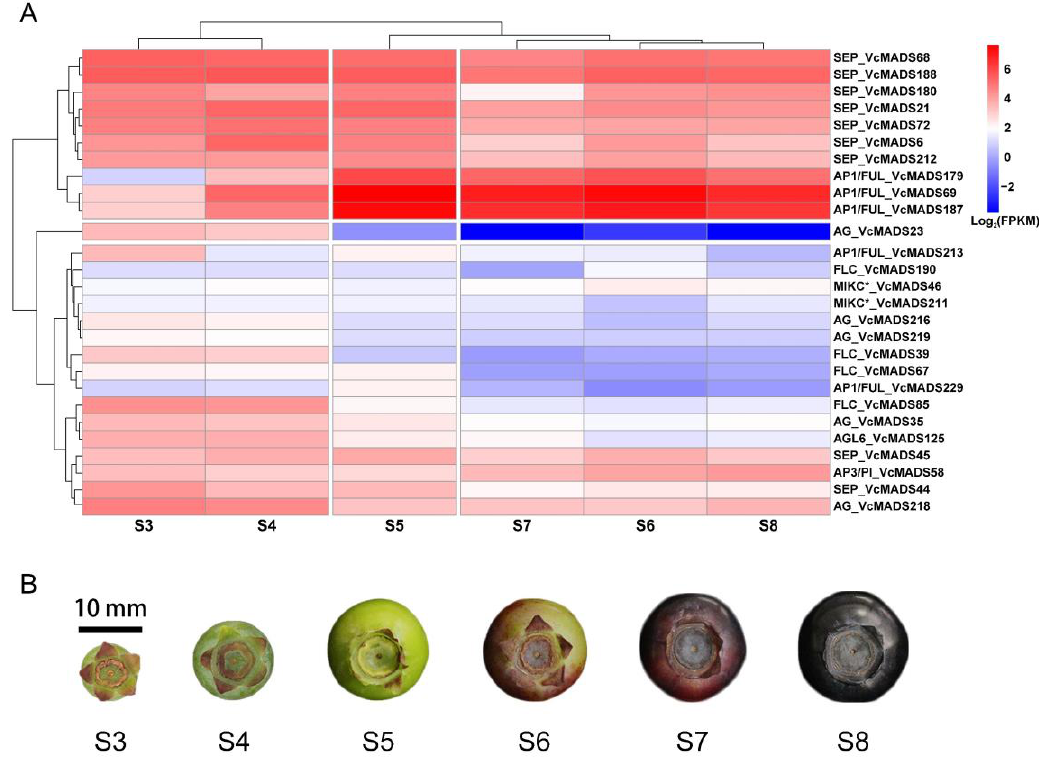
Figure 8. The heat map of 27 VcMADS genes highly expressed during blueberry fruit ripening. ( A ) Expression values were quantified as fragments per kilobase per million reads (FPKM) and normalized by taking logarithms. The rows and columns of the heat map were clustered. The row clustering clustered genes with similar expression patterns from S3 to S8, and the column clustering clustered similar stages based on the expression levels of 27 genes in different stages. ( B ) Six different stages of blueberry during fruit ripening. Blueberry fruit mainly expanded in the S3–S5 stages and changed color in the S6–S8 stages.